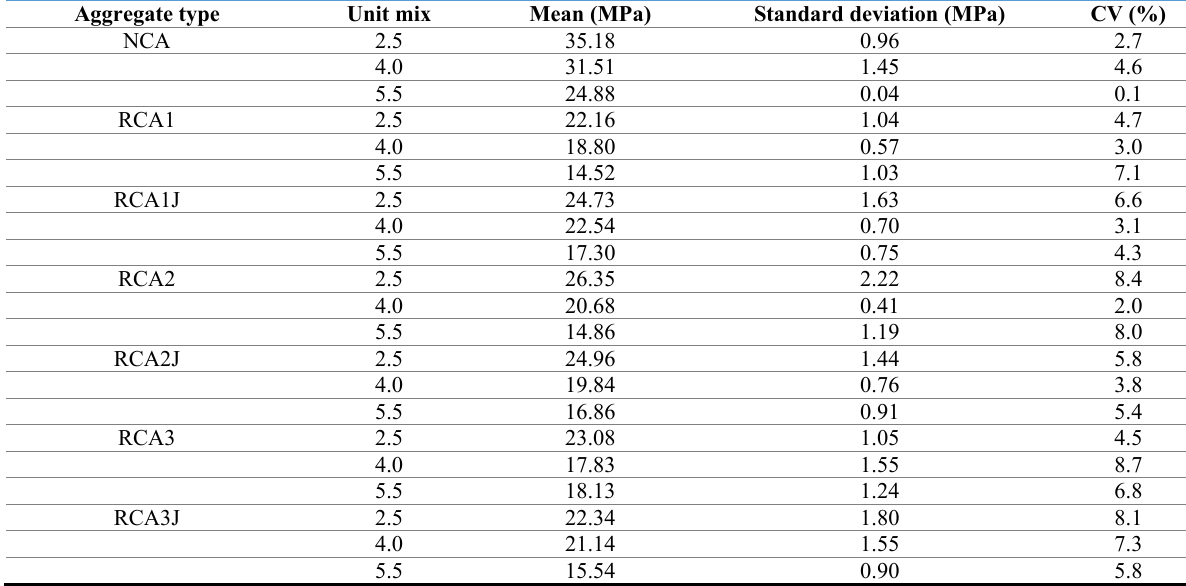
Table 5. Mean, standard deviation and coefficient of variation of axial compressive strength (MPa). Aggregate type